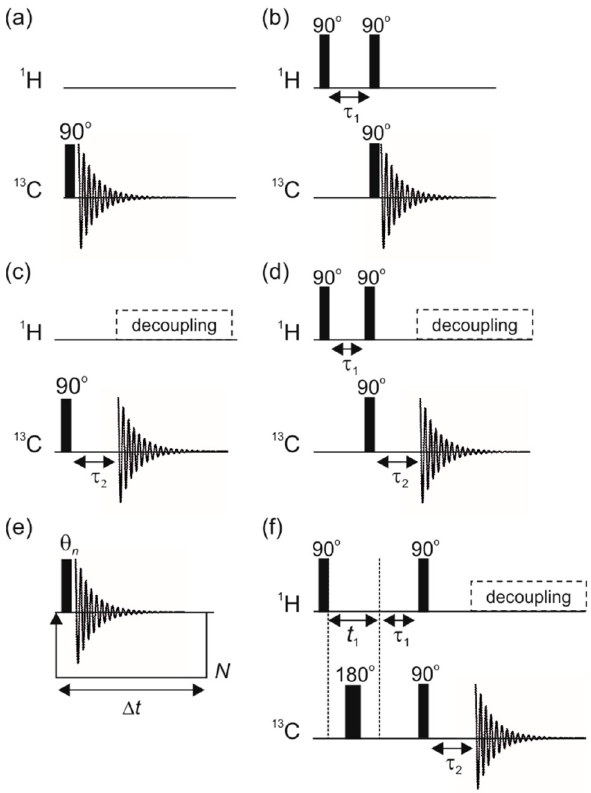
= 1/2 J = 1/3 J CH and τ 2 CH . ( a ) Pulse and acquire (PA)